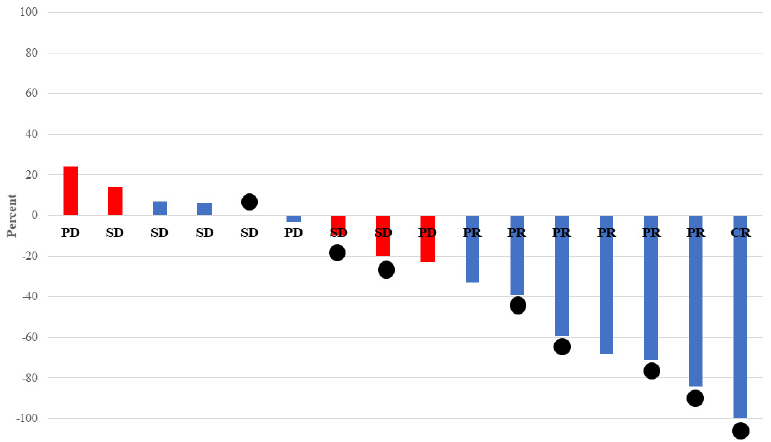
Figure 3. Best rate of change from baseline in total measurable tumor diameter. Blue: Prior use of ICI ( n = 10): (RR: 60%), Red: no prior use of ICI ( n = 6): (RR: 14%), ● : Tmab-free interval over 8 months ( n = 8): (RR: 75%).